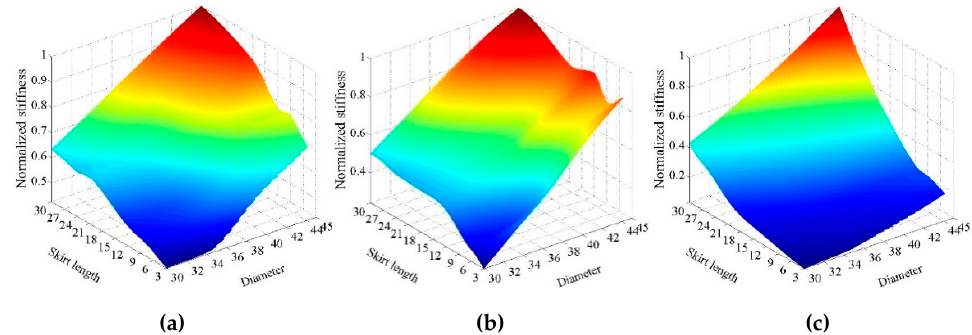
Figure 20. Variation of three dynamic stiffness coefficients at dimensionless excitation frequency of 4: ( a ) Horizontal stiffness; ( b ) coupling stiffness; ( c ) rocking stiffness.